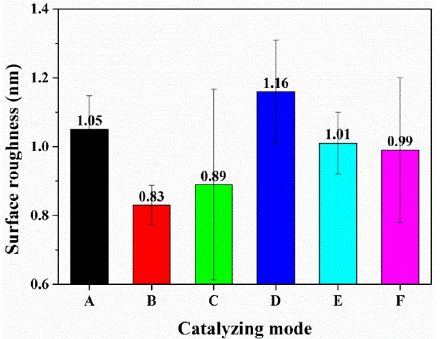
Figure 4. Surface roughness of sapphire substrates after polishing under different catalyzing modes: ( A ) pristine pad, ( B ) synthetic soft abrasives, ( C ) citric acid, ( D ) theophylline, ( E ) green tea powder, and ( F ) coffee powder.